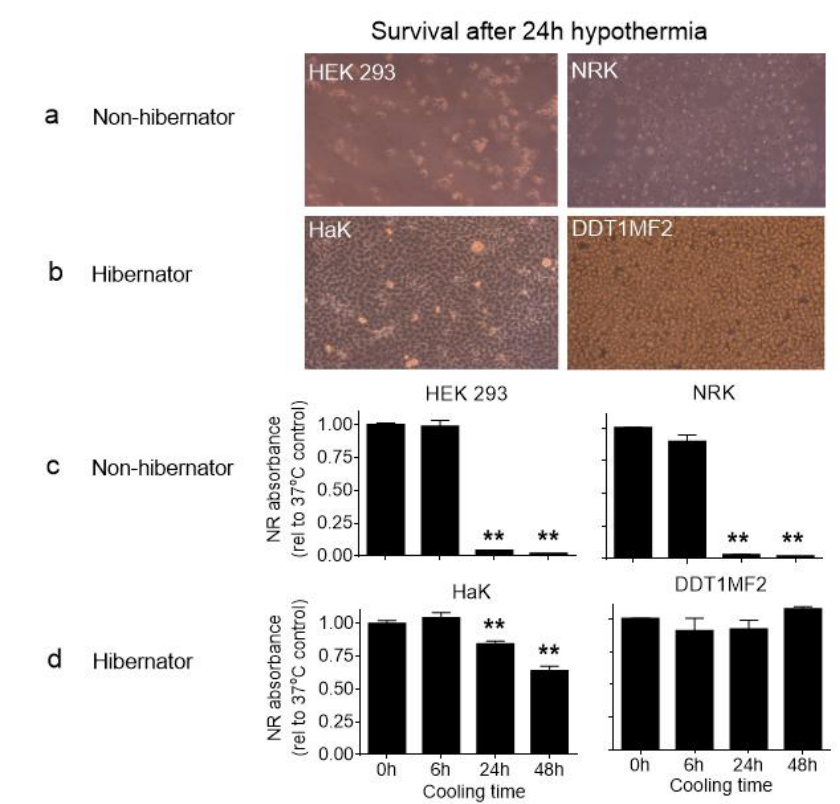
Figure 1. Cell survival after hypothermia in non-hibernator and hibernator-derived cell lines. ( a ) microscopic images (100 × ) after 24 h hypothermia of the non-hibernation derived HEK293 (human embryonic kidney 293) and NRK (normal rat kidney cells) and ( b ) hibernator derived HaK (hamster kidney) and DDT1MF2 (ductus deferens tumor). ( c ) Cell survival measured as neutral red (NR) absorbance, expressed relatively to non-cooled cells in HEK293 and NRK and ( d ) HaK and DDT1MF2. Data presented as mean ± SD. ** = p < 0.01; ANOVA post hoc Bonferroni.